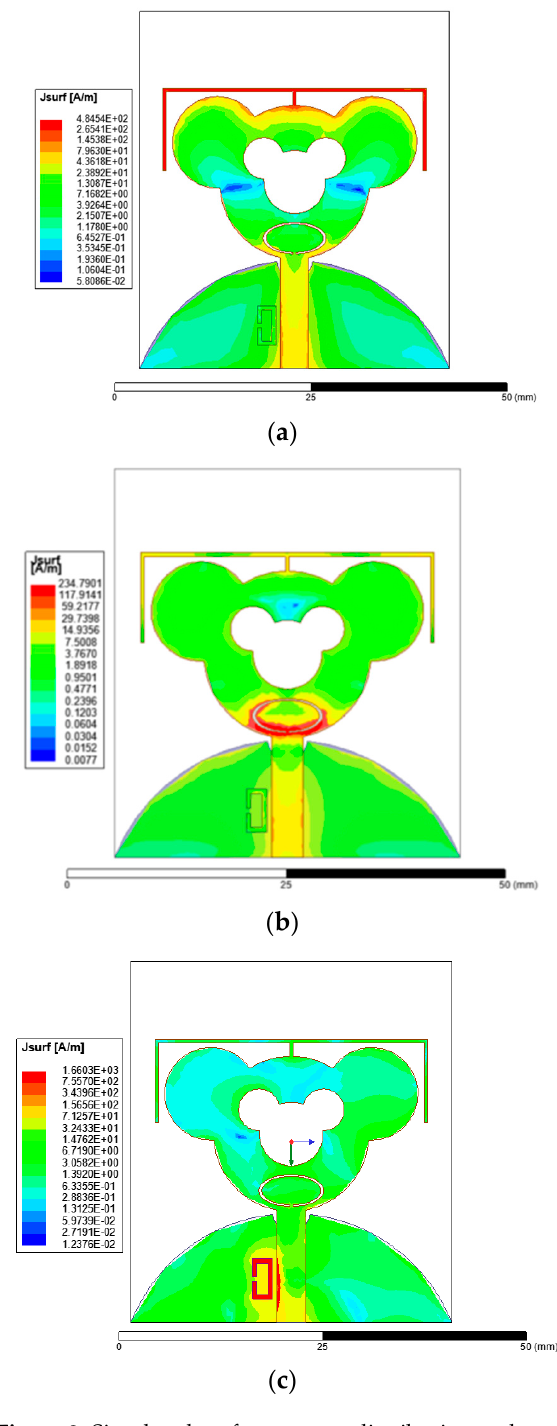
Figure 9. Simulated surface current distribution at the notch frequency ( a ) at 2 GHz with E-shaped stub, ( b ) at 6 GHz with split elliptical slot, and ( c ) at 10 GHz with C-shaped resonator.